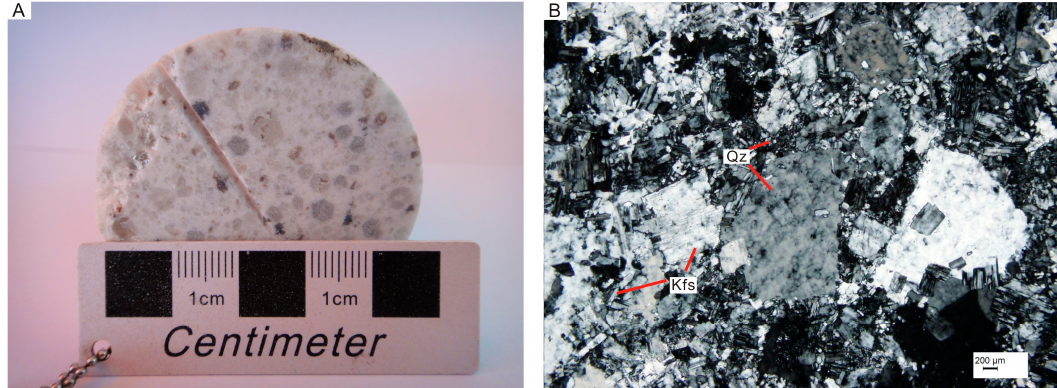
Figure 3. ( A ) Characteristic features of quartz porphyry; ( B ) Photomicrographs of quartz porphyry. Abbreviations: Qz—quartz; Kfs—K-feldspar.